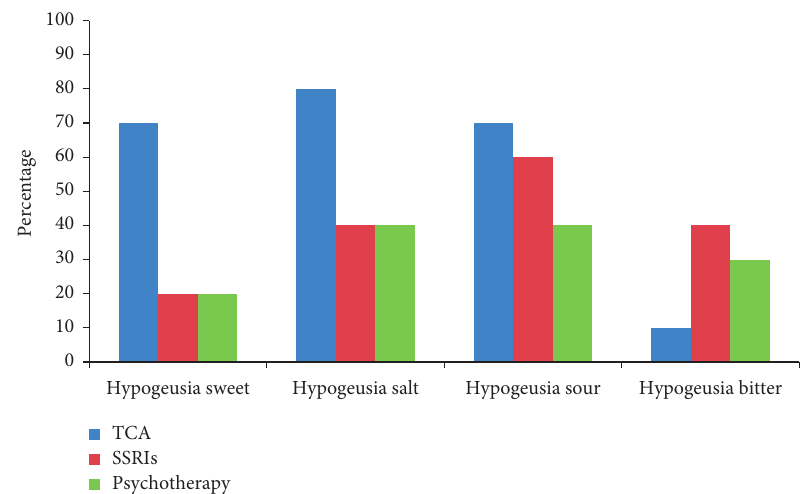
Figure 3: Bar chart representing sweet, salt, sour, and bitter hypogeusia among the studied